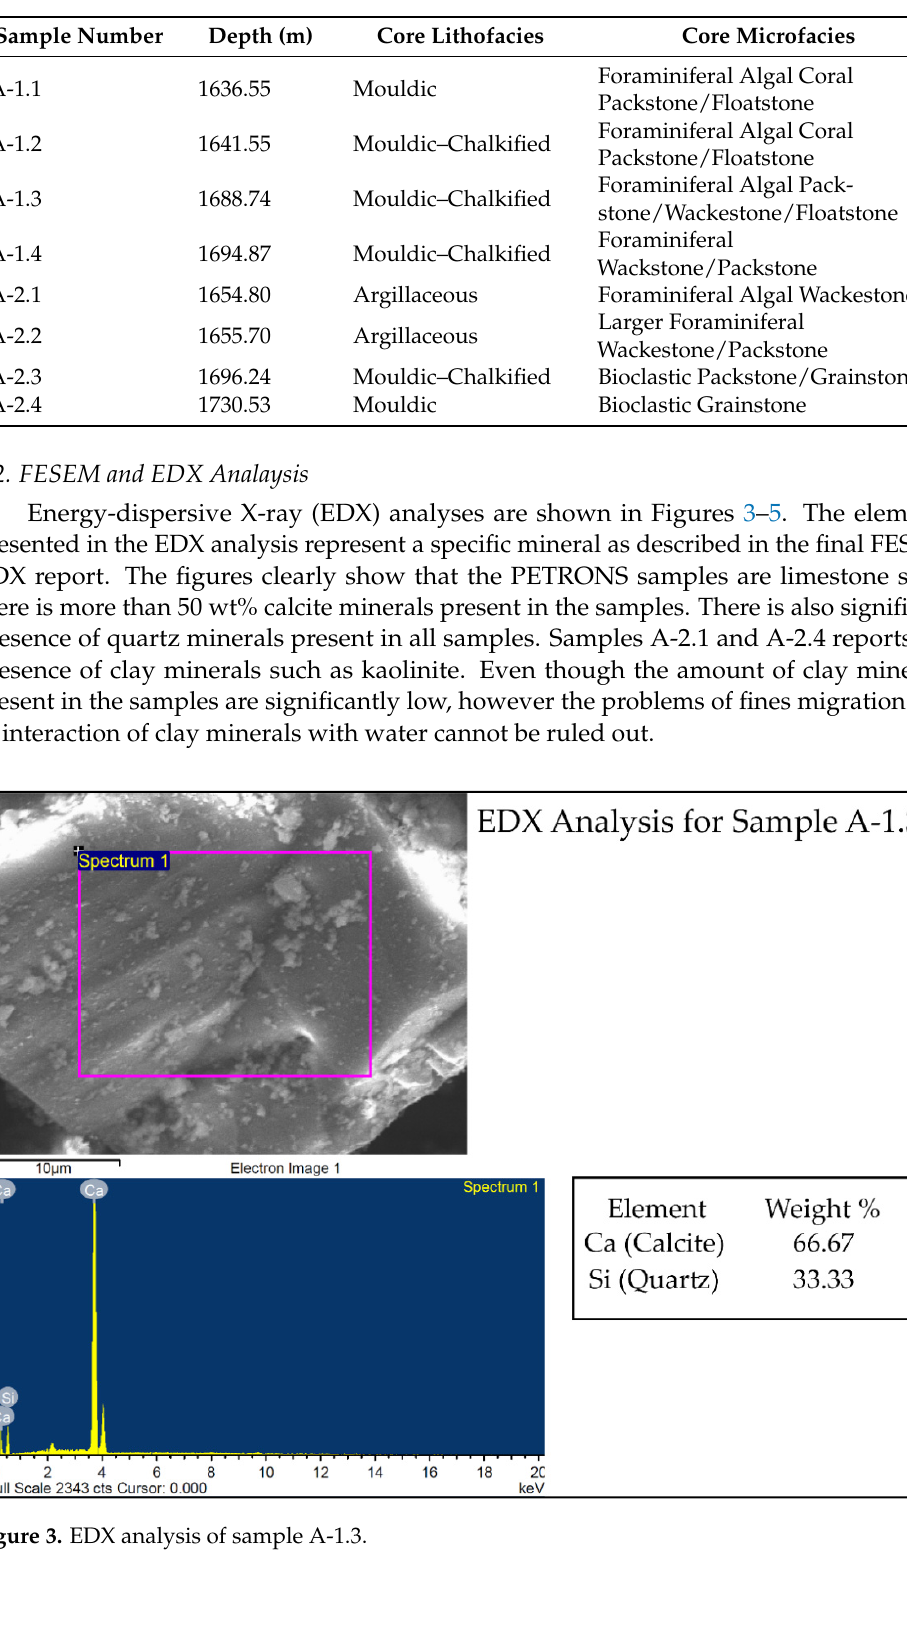
Figure 4. EDX analysis of sample A-2.1.